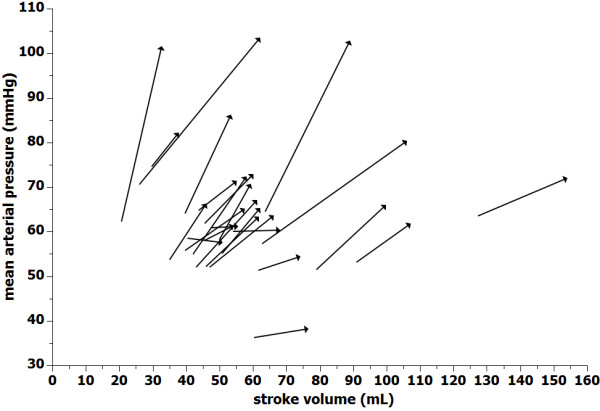
Mean arterial pressure (MAP) and stroke volume response to volume loading. Arrows indicate individual changes in stroke volume and mean arterial pressure after fluid administration.